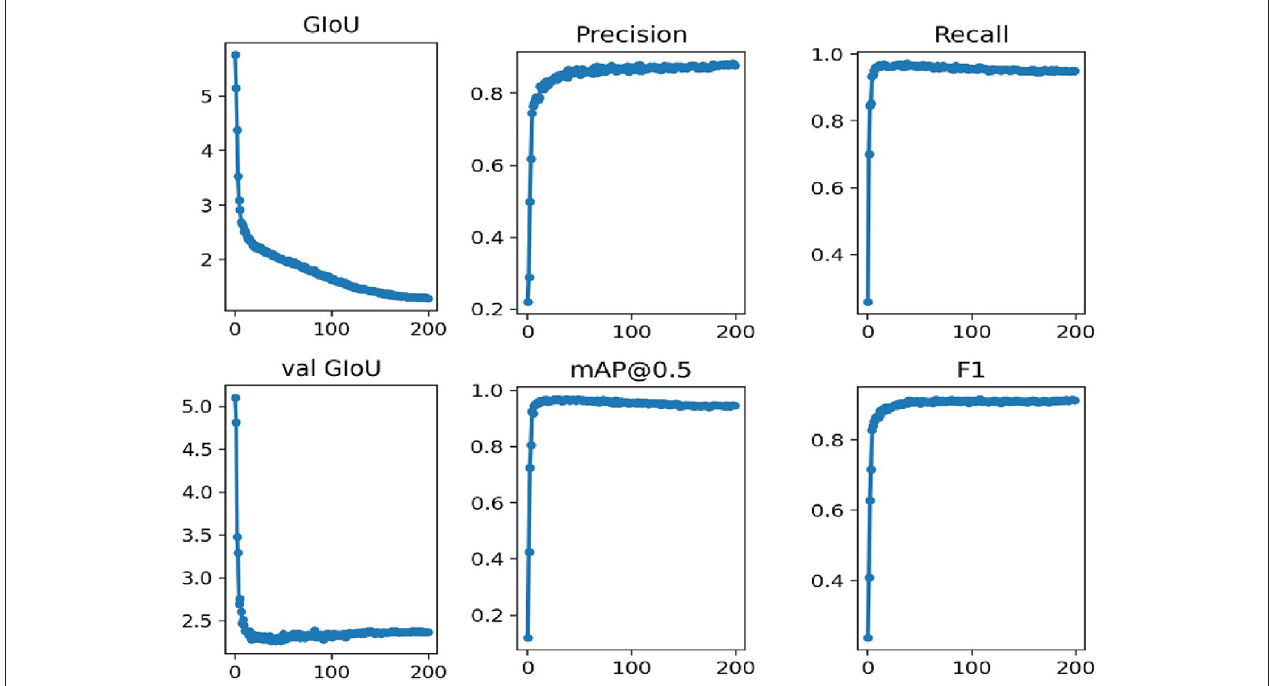
FIGURE 5 | The training performance of the original dataset YOLOv3-SPP